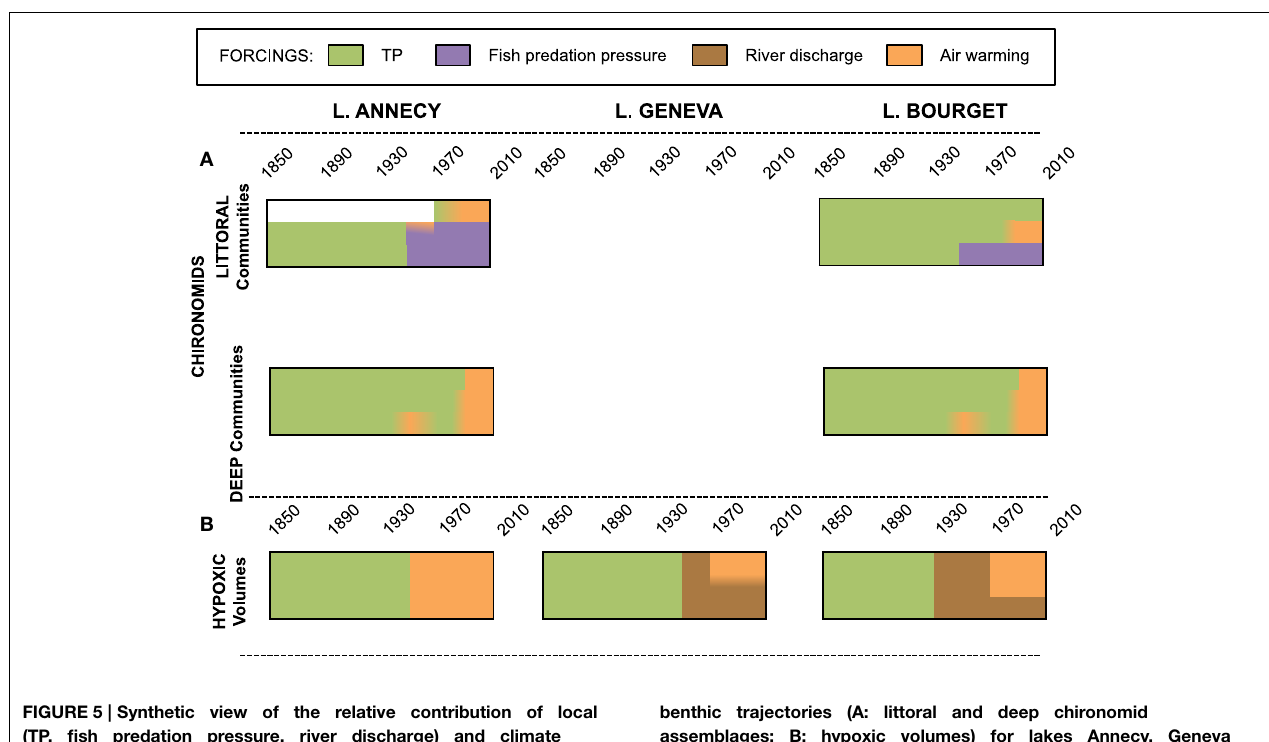
benthic trajectories (A: littoral and deep chironomid assemblages; B: hypoxic volumes) for lakes Annecy, Geneva and